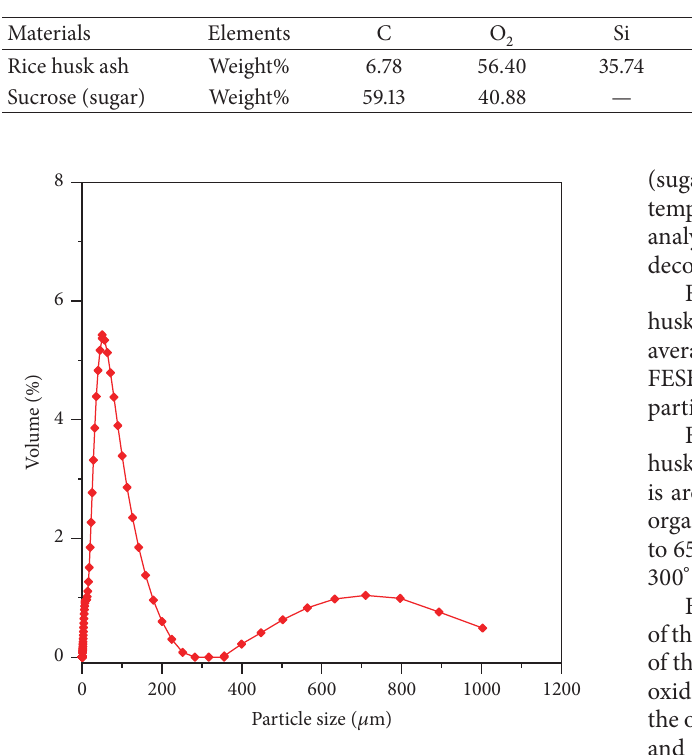
Table 1: The chemical compositions of rice husk ash powder and sucrose.